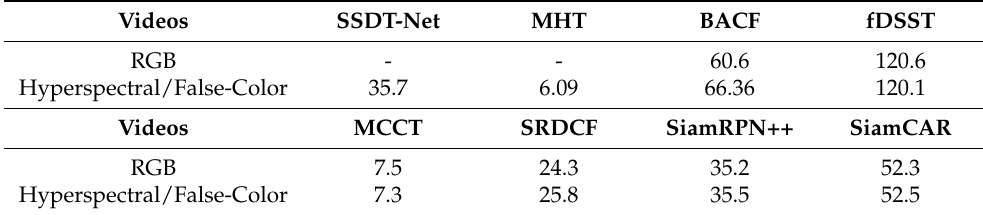
Table 4. Running time comparison